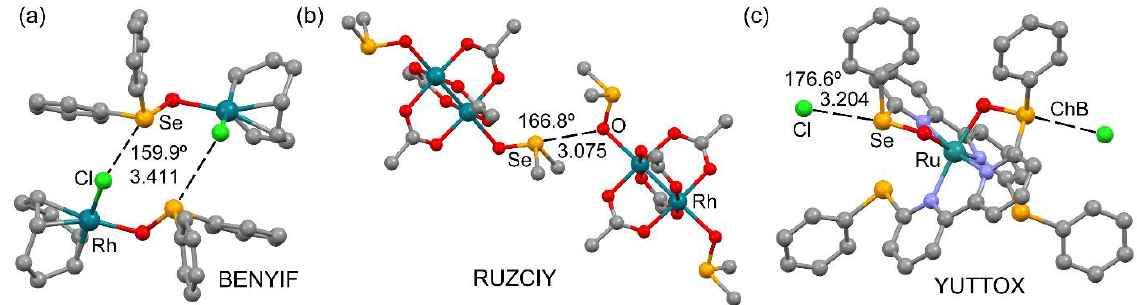
Figure 4. X-ray structures of BENYIF ( a ), RUZCIY ( b ), and YUTTOX ( c ). H atoms omitted and distances in